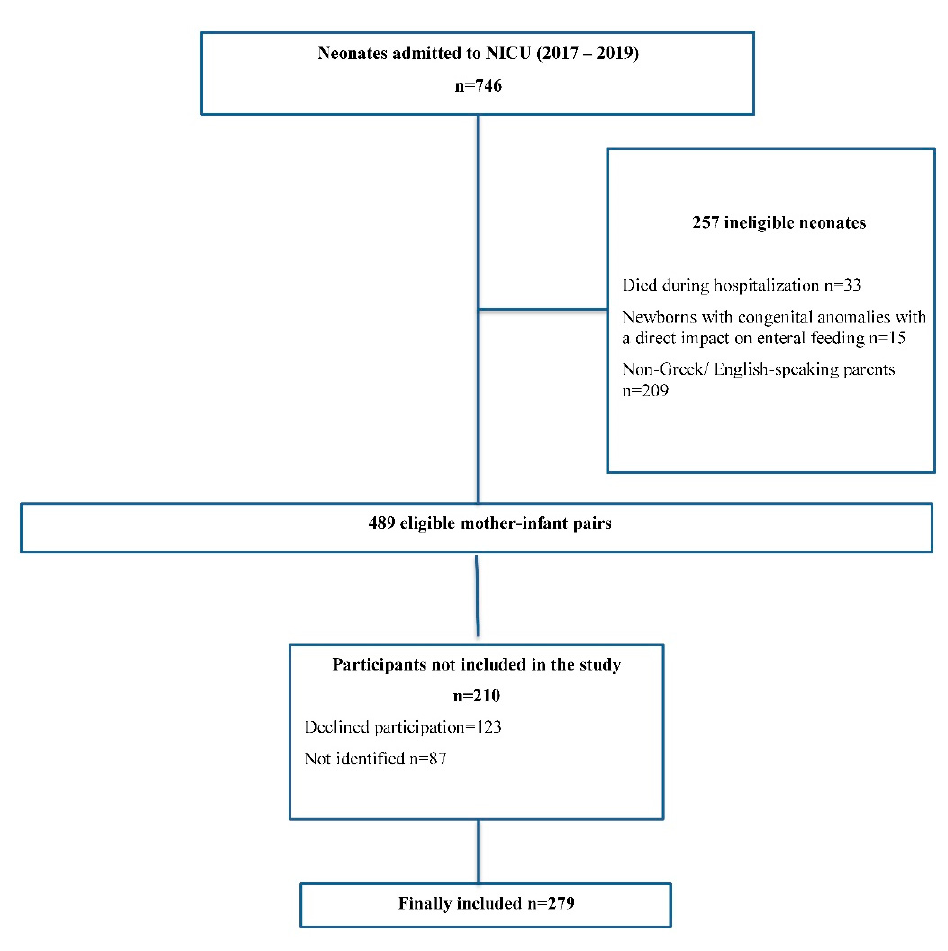
Figure 1. Flow chart of the study population.